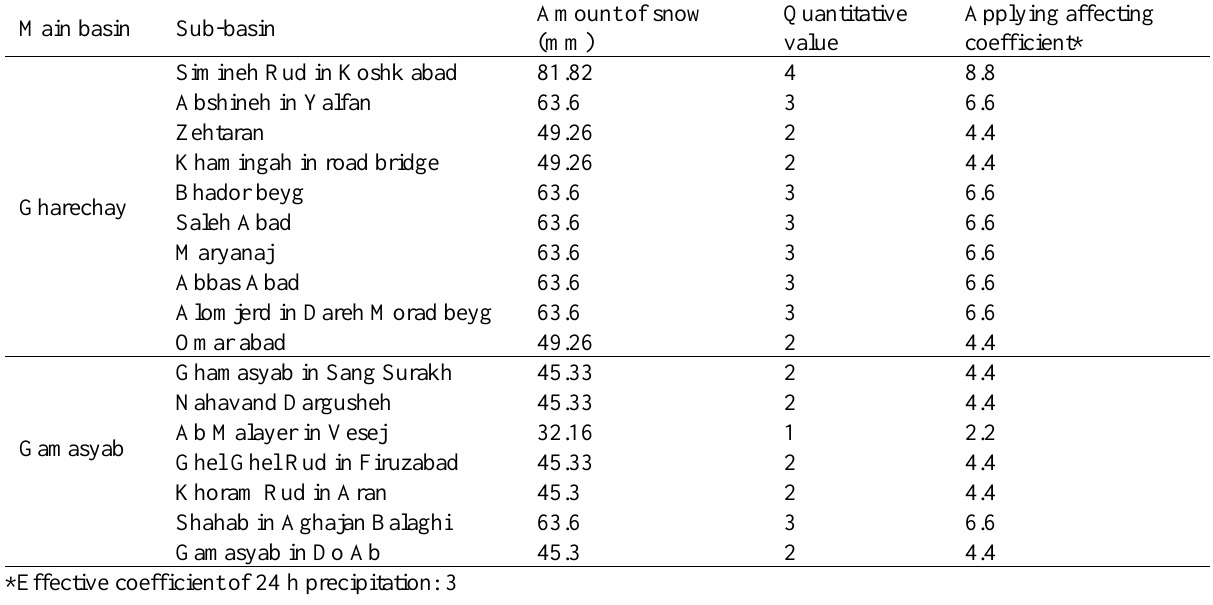
Table 1. Cumulative mean maximum 24 h precipitation of Gamasyab and Gharechay sub-basins Main basin Sub-basin